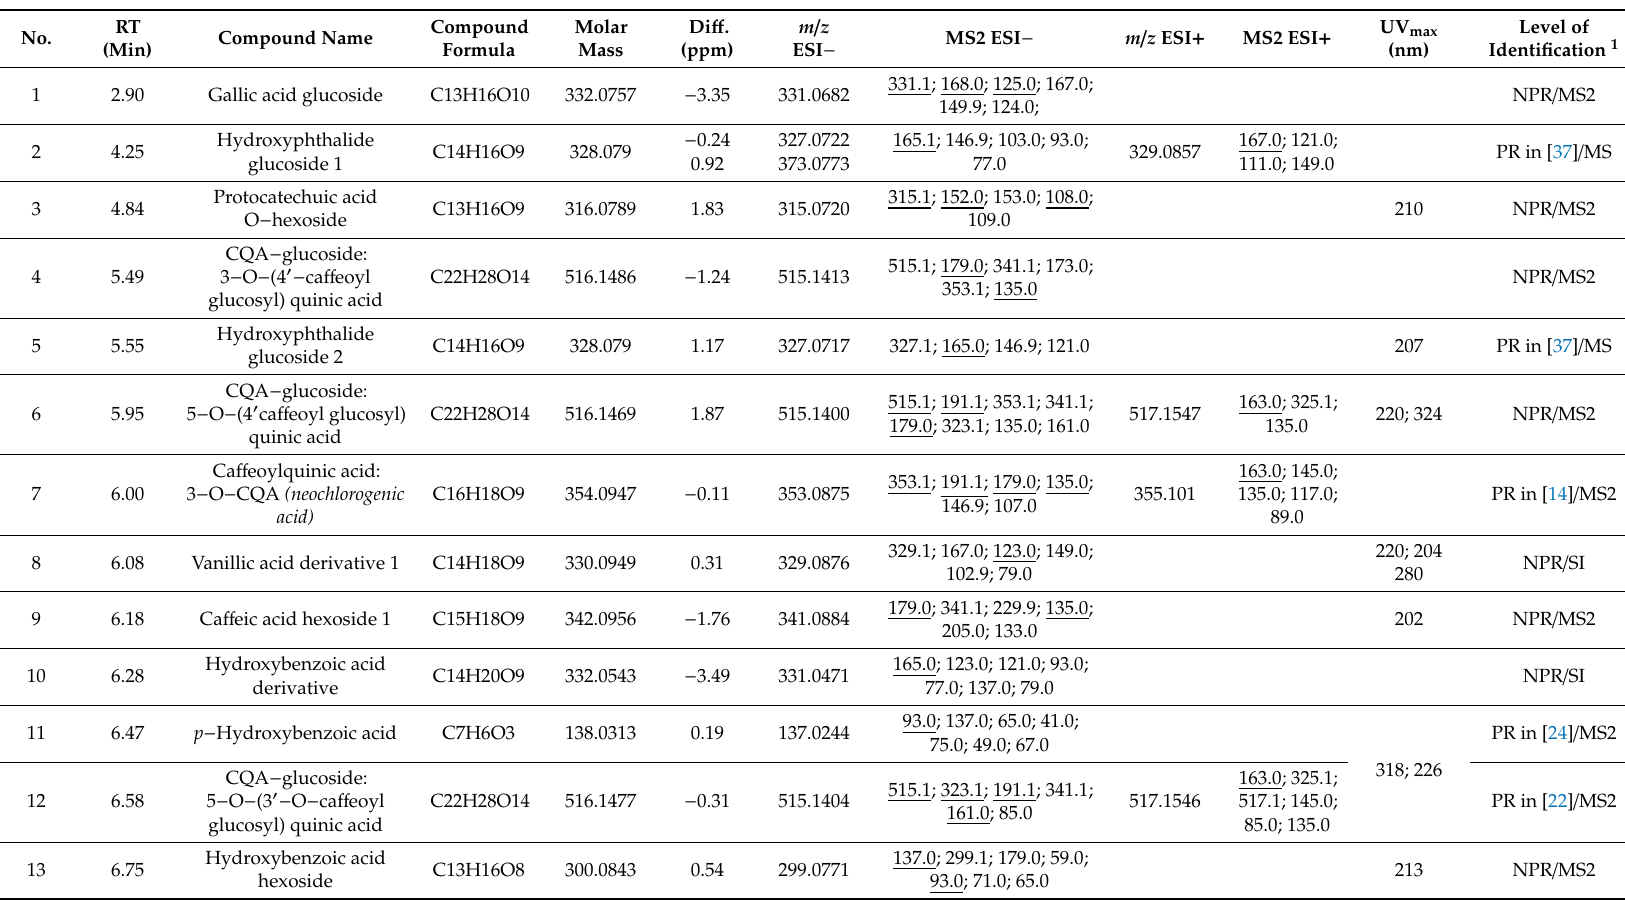
Table A1. Comprehensive chromatographic and spectral data of the (tentatively) identified compounds in H. italicum extracts obtained with HPLC-DAD-ESI-QTOF-MS.